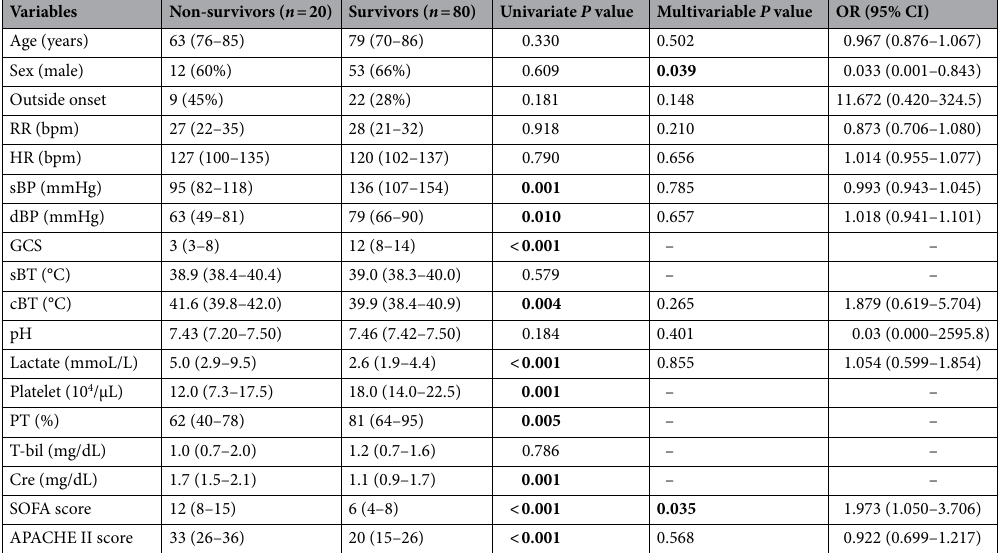
Table 2. Univariate and multivariable comparisons between survivors and non-survivors at 28 days in classical cases. Values are median (interquartile range) or n (%) of cases. OR odds ratio; CI confidence interval; RR respiratory rate; HR heart rate; sBP systolic blood pressure; dBP diastolic blood pressure; GCS Glasgow Coma Scale; sBT surface body temperature; cBT core body temperature; PT prothrombin time; T-bil total bilirubin; Cre creatinine; SOFA Sequential Organ Failure Assessment; APACHE Acute Physiology and Chronic Health Evaluation. Significant values are in bold.